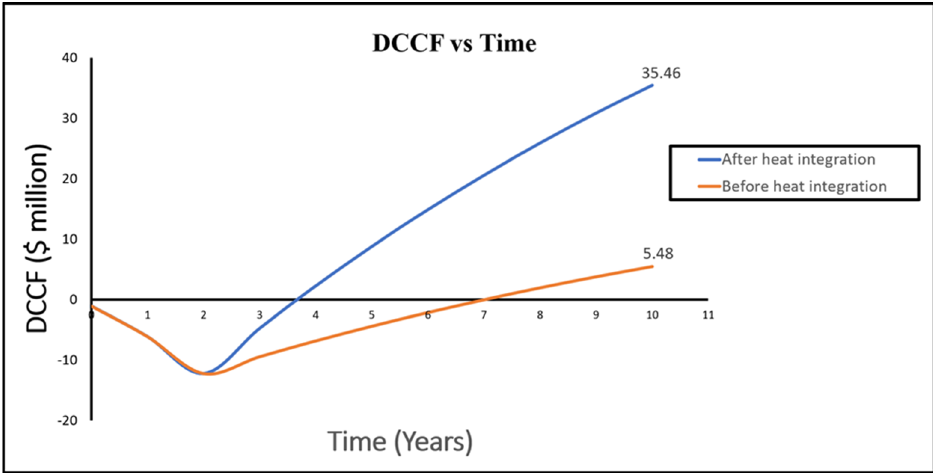
Figure 9. DCCF with respect to time in a 10-year profitability analysis.